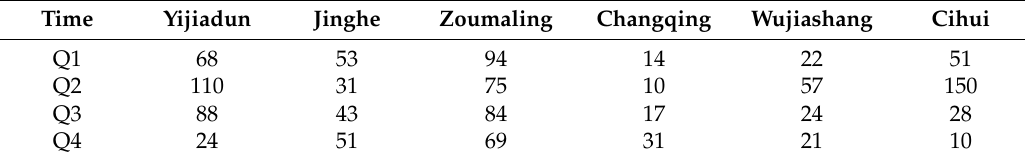
Table 3. Global theft rate ranking of Chihui Community and adjoining communities. Time